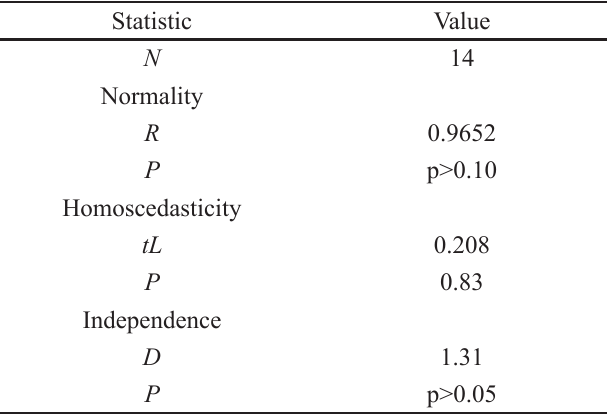
regression residues, respectively (Table I.) TABLE I - Statistical parameters for linear regression evaluation